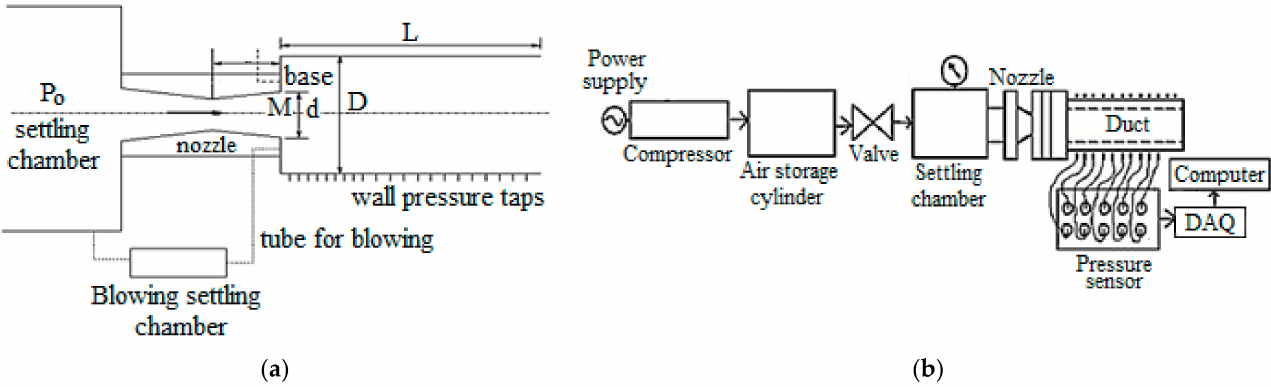
Figure 3. Experimental setup; ( a ) Nozzle connections with the settling chamber and duct; ( b ) Data acquisition system for base pressure through the expanded